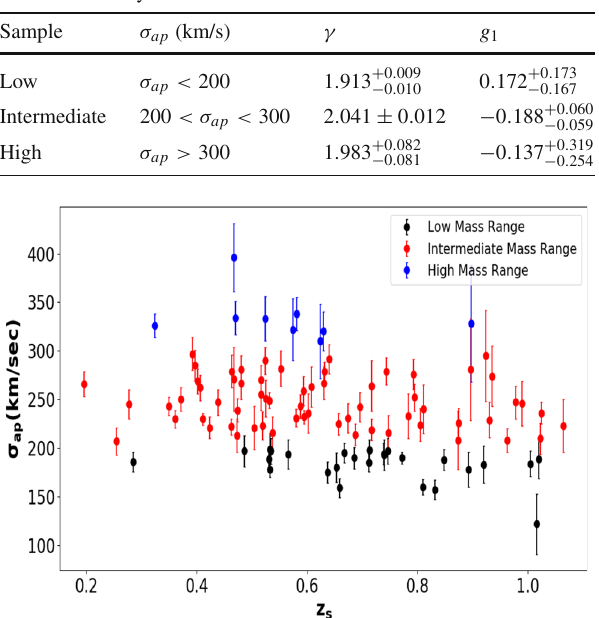
Table 1 Constraints on the parameters γ and g 1 for different σ ap range used in this analysis as discussed in Sect. 4